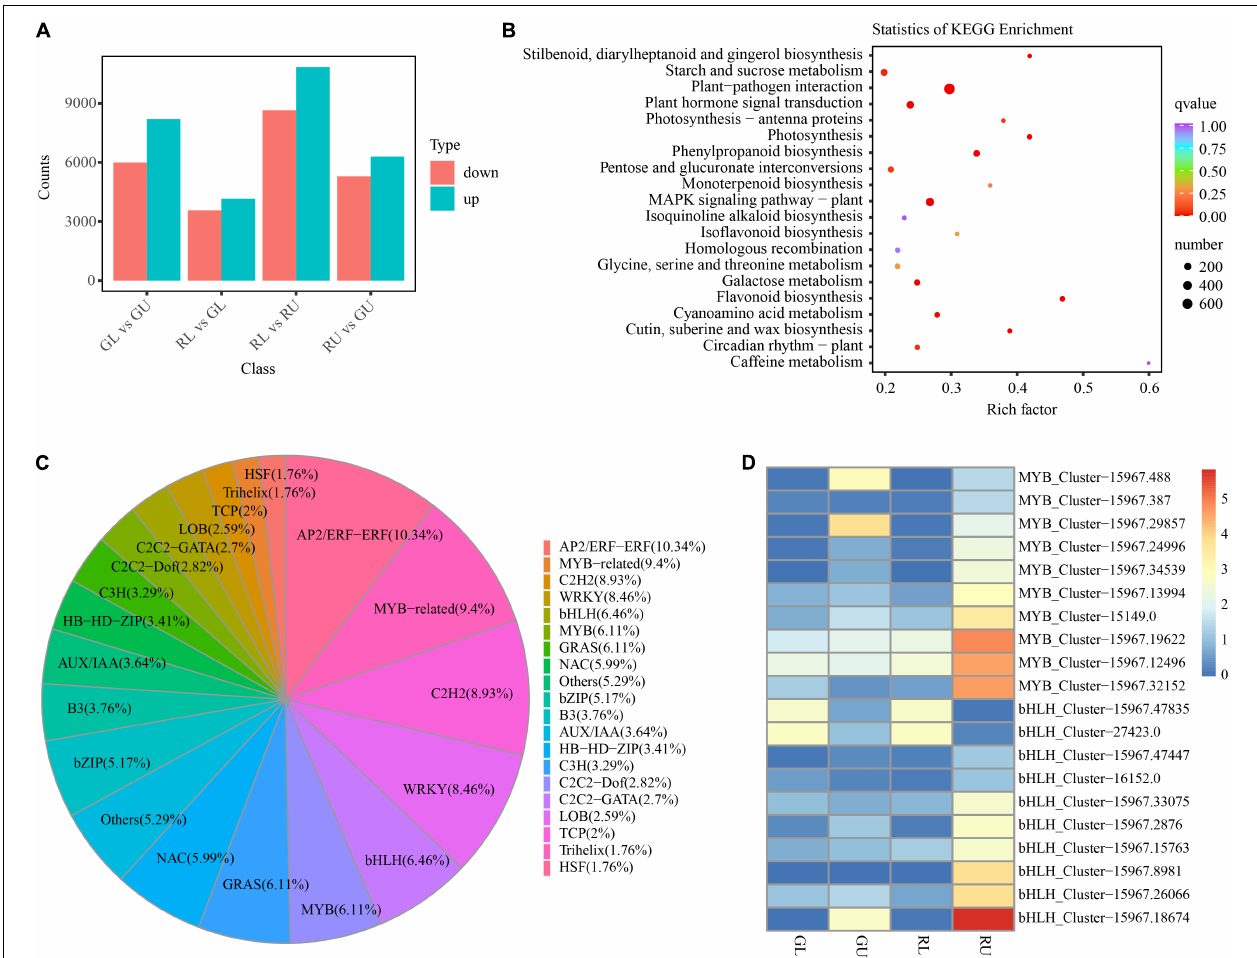
FIGURE 4 | DEGs in H. hainanensis . (A) DEGs from different comparisons. (B) The KEGG enrichment of DEGs in RU vs. GU ( Q values are corrected p values scaled by the number of comparisons, with 0 being highly significant and 1 being not significant). (C) Distribution of all differentially expressed transcription factors. (D) heatmap of the MYB and bHLH transcription factors from RU vs. GU and RL vs. RU with | log2Fold Change| ≥ 2, colors indicate log2Fpkm.